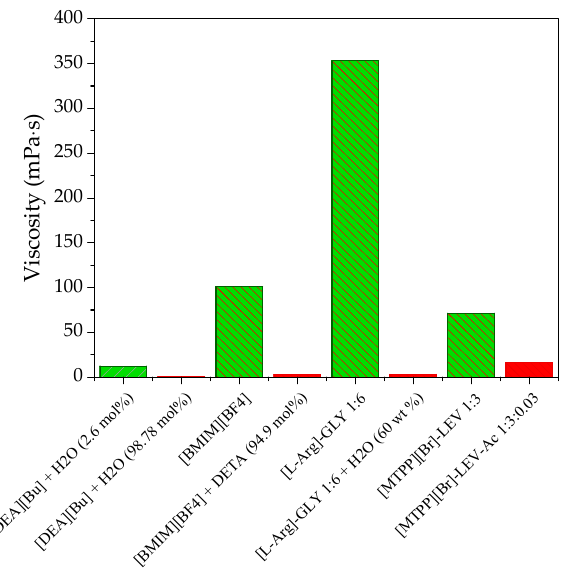
Figure 5. Comparison of viscosity for IL and IL-based hybrid solvent, as well as DES and DES-based hybrid solvent at 333.15 K and 0.1 MPa.